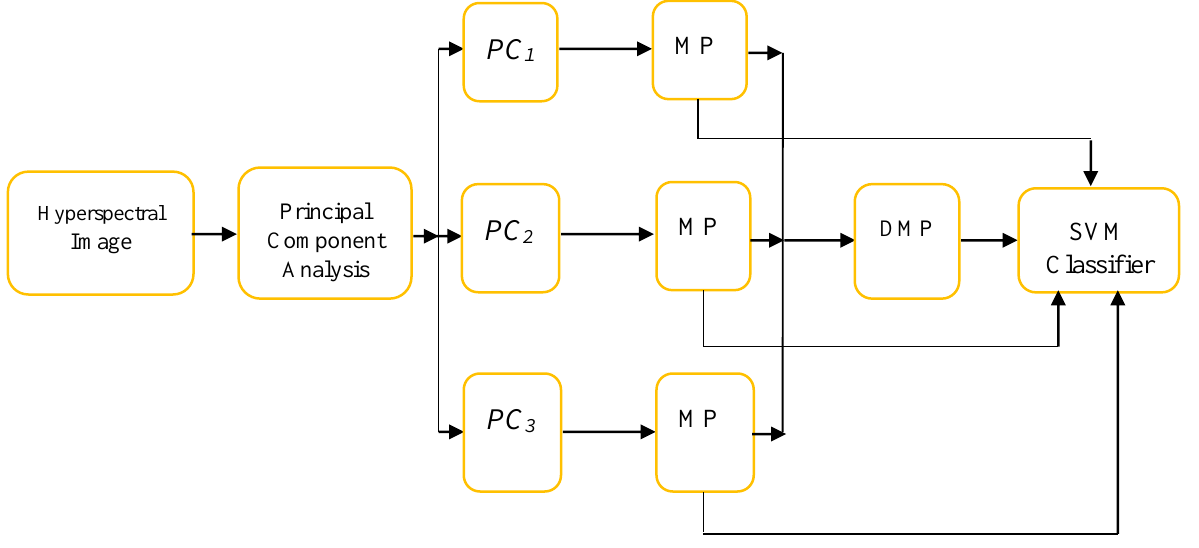
Figure 1 . Block diagram of the proposed method for spatial feature extraction